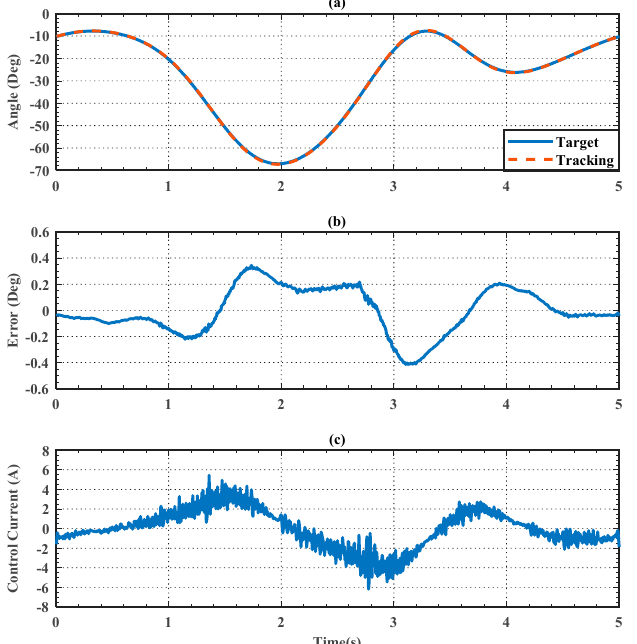
Figure 12. Right knee joint trajectory tracking for LES with the ILESO − PSMC. ( a ) Knee joint angle tracking response; ( b ) knee joint angle tracking error; ( c ) current control signal.